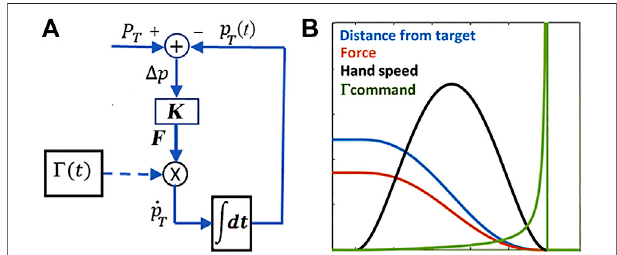
FIGURE 2 | (A) : PMP model for the generation of a p T ( t ) moving target aimed to the fi nal target P T . The virtual force fi eld F is gated by the Γ -function that indirectly control the speed pro fi le _ p T ( t ) . (B) shows that the spiky Γ - command induces a bell-shaped speed pro fi le with the corresponding smooth reduction of the distance from the